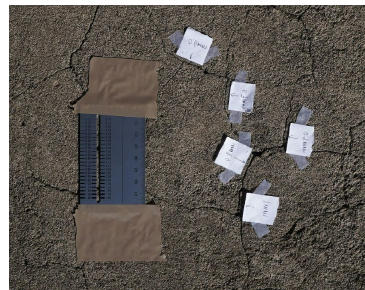
Figure 11. Crack measuring gauge and labeled cracks. The gauge's function is to obtain each pixel's actual dimension.